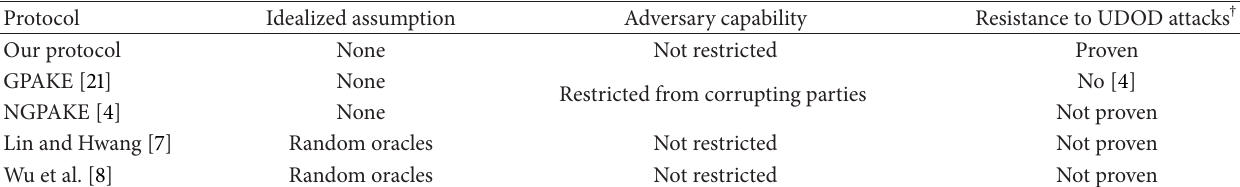
Table 1: Security proof